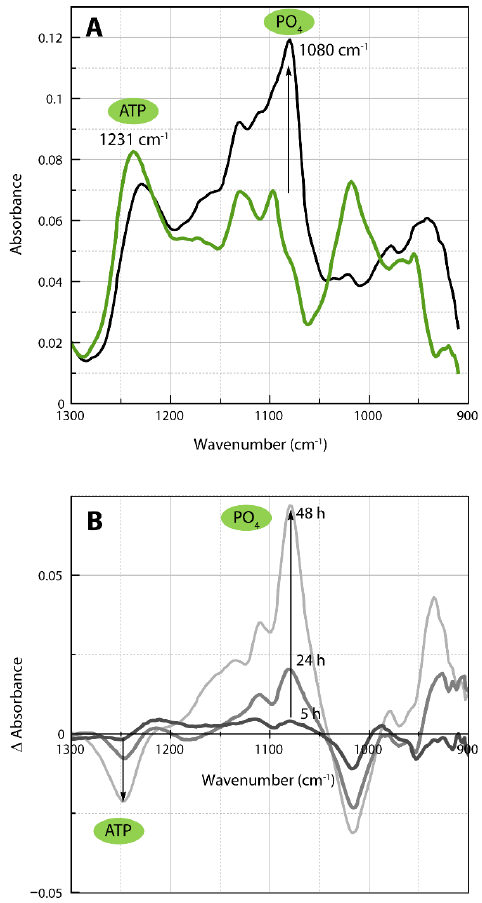
Figure 4. IR spectra of extracellular medium containing 50 mM ATP extracted from MOVAS after 14 days of incubation in osteogenic medium. ( A ) IR spectra obtained after 3 h (green) and 48 h (black) of ATP hydrolysis by extracellular phosphatases. ( B ) Successive IR difference spectra. ATP hydrolysis was monitored at the indicated incubation time. Dark gray: 5 h minus 3 h, medium gray: 24 h minus 3 h, light gray: 48 h minus 3 h.